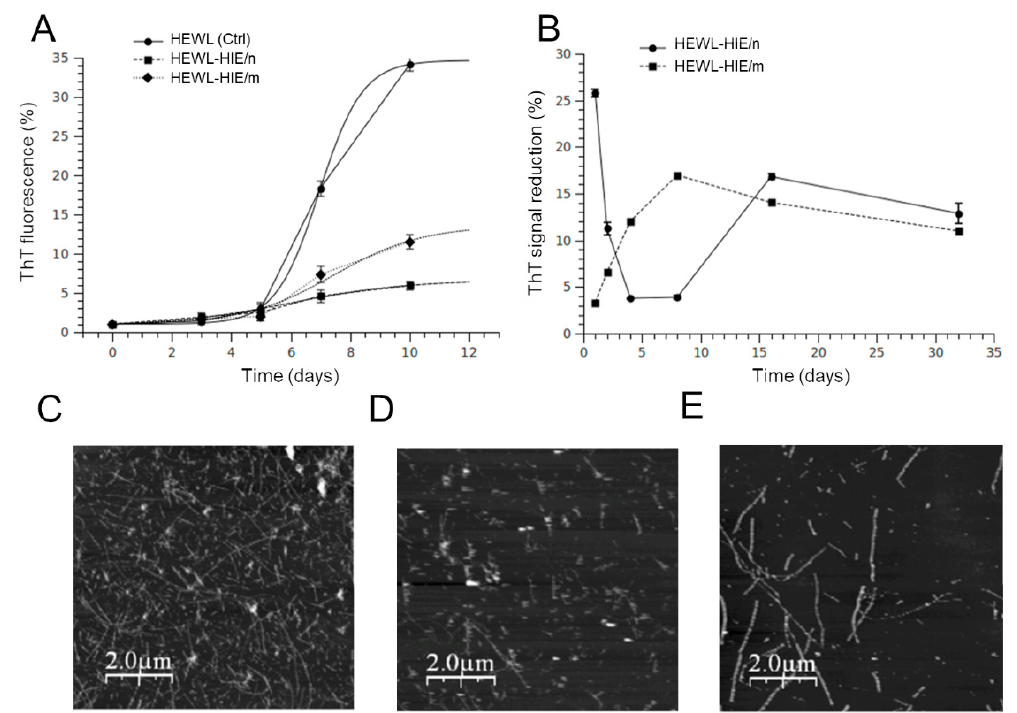
Figure 4. E ff ect of the HIEs on the HEWL amyloid aggregates formation. ( A ) Kinetic plots followed by ThT fluorescence signals. Plots report the ThT fluorescence signals at di ff erent times with respect to that at 0 days. ( B ) ThT competition assay. Preformed HEWL fibrils were incubated with ThT dye in the presence of HIE / m or HIE / n. ( C – E ) Representative AFM morphological analysis images